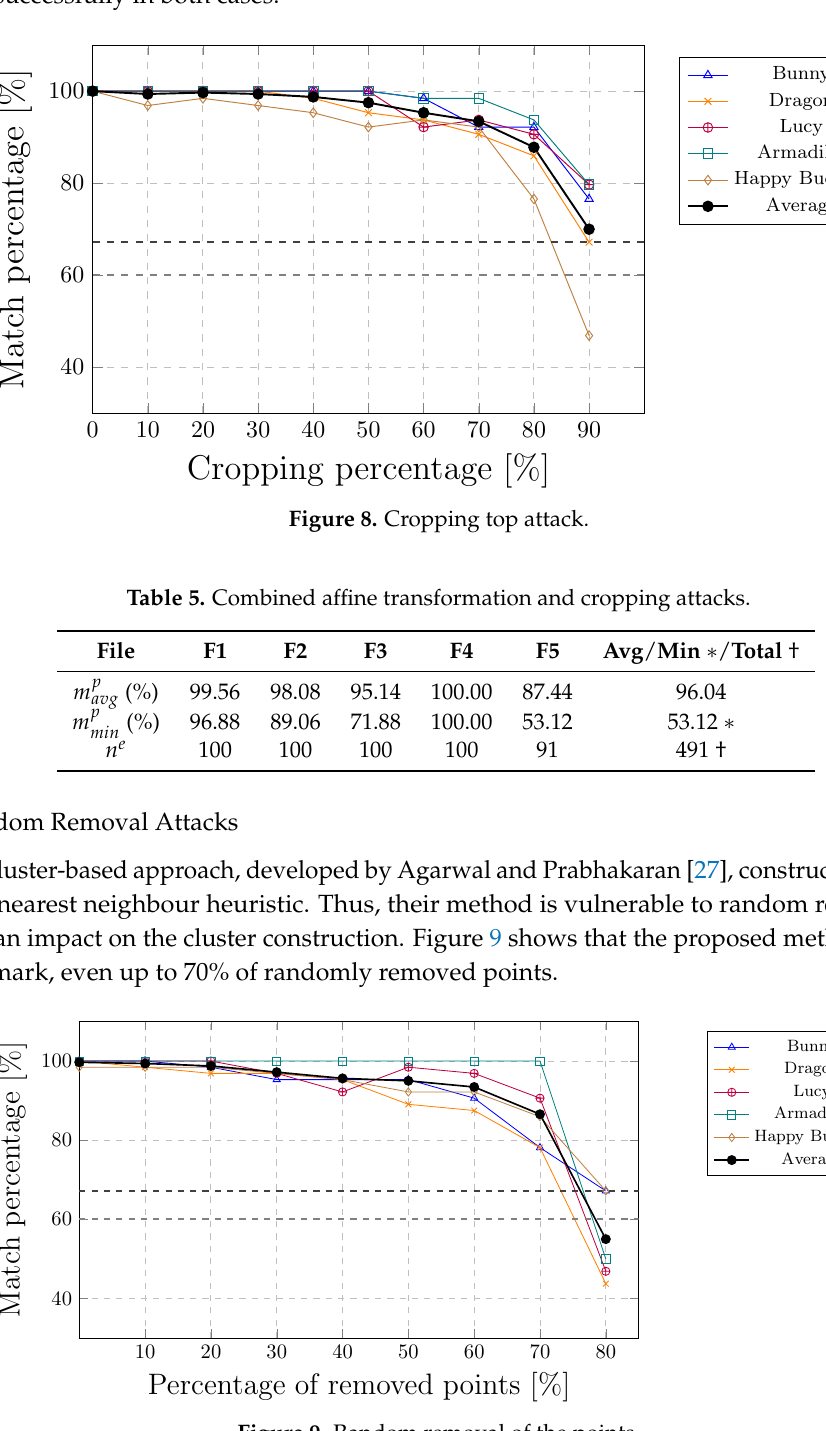
Figure 9. Random removal of the